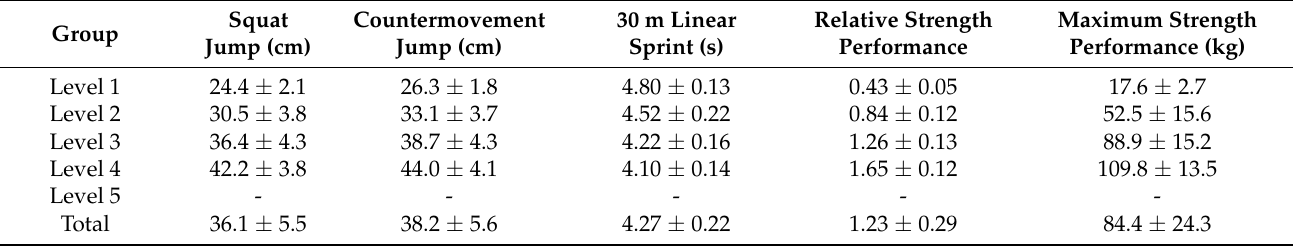
Table 2. Means and standard deviations of performance